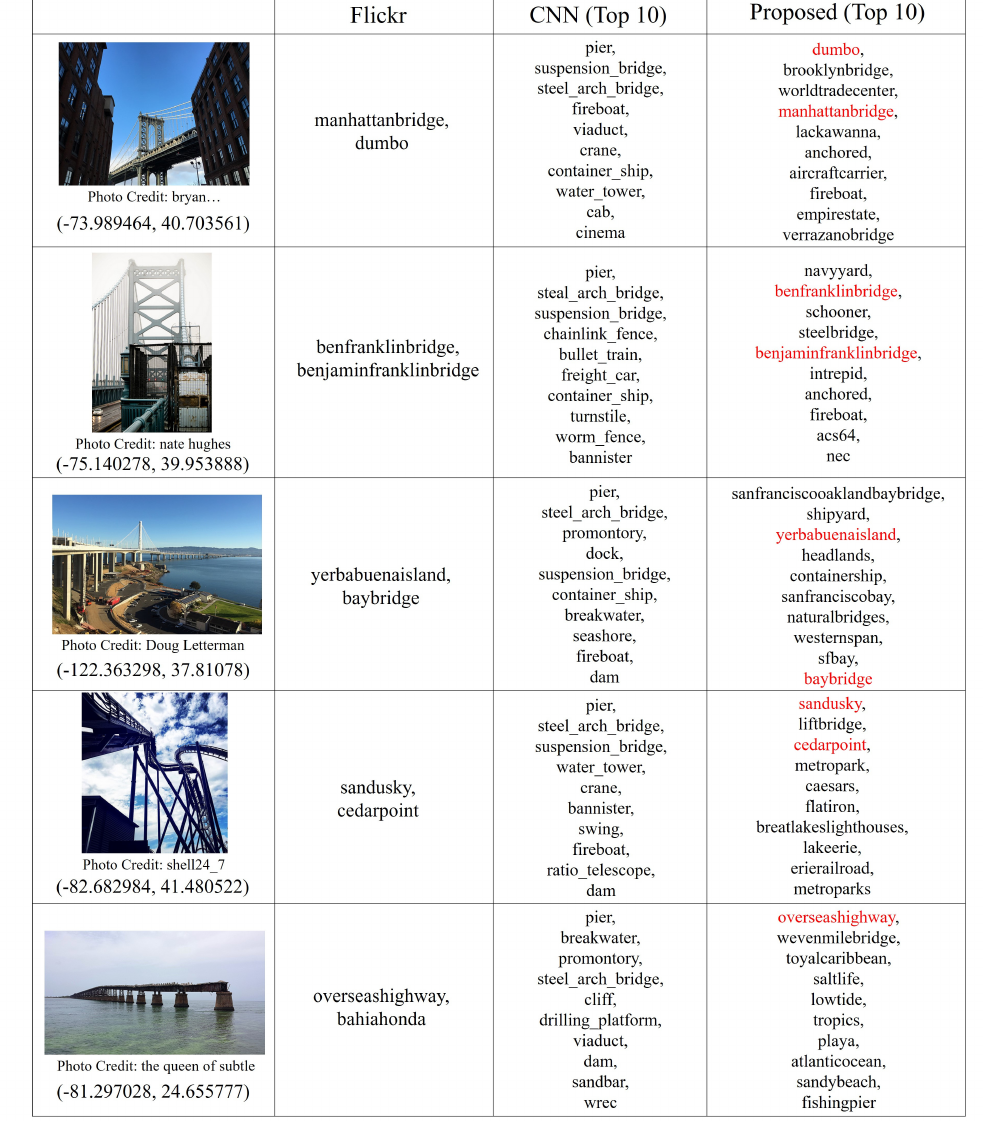
Figure 18. Examples of image recognition results for visually similar test images captured at different